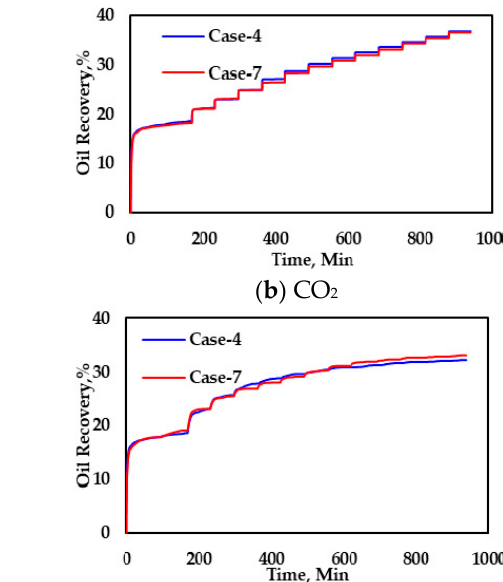
Figure 25. Oil saturation comparison with gravity effect (ij profile). 3.2. Fracture Characteristics Now that the fundamental mechanisms of huff-‘n-puff by using CO 2 , N 2 and water are clear, it is of interest to understand how the distribution of fractures affects their performance in huff-‘n-puff. For different fracture characteristics, the direction of scattered fracture, fracture in end face or lateral face, Scattered pattern of fractures, fracture relative location with well and fracture area are designed to mechanistically understand the impact of fracture characteristics on huff-‘n-puff.